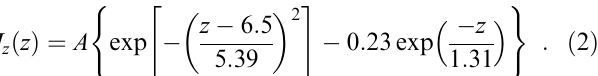
Table 1. The IR brightness temperature intervals used in Janowiak et al. (1994) and in the present study Histogram class Temperature limits (K)